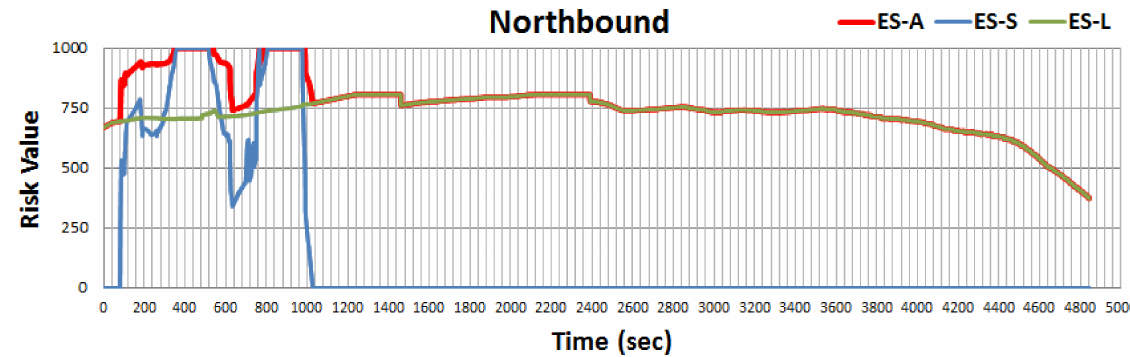
Figure 1. Graphic representation of maneuvering difficulties for 330 m Bulk